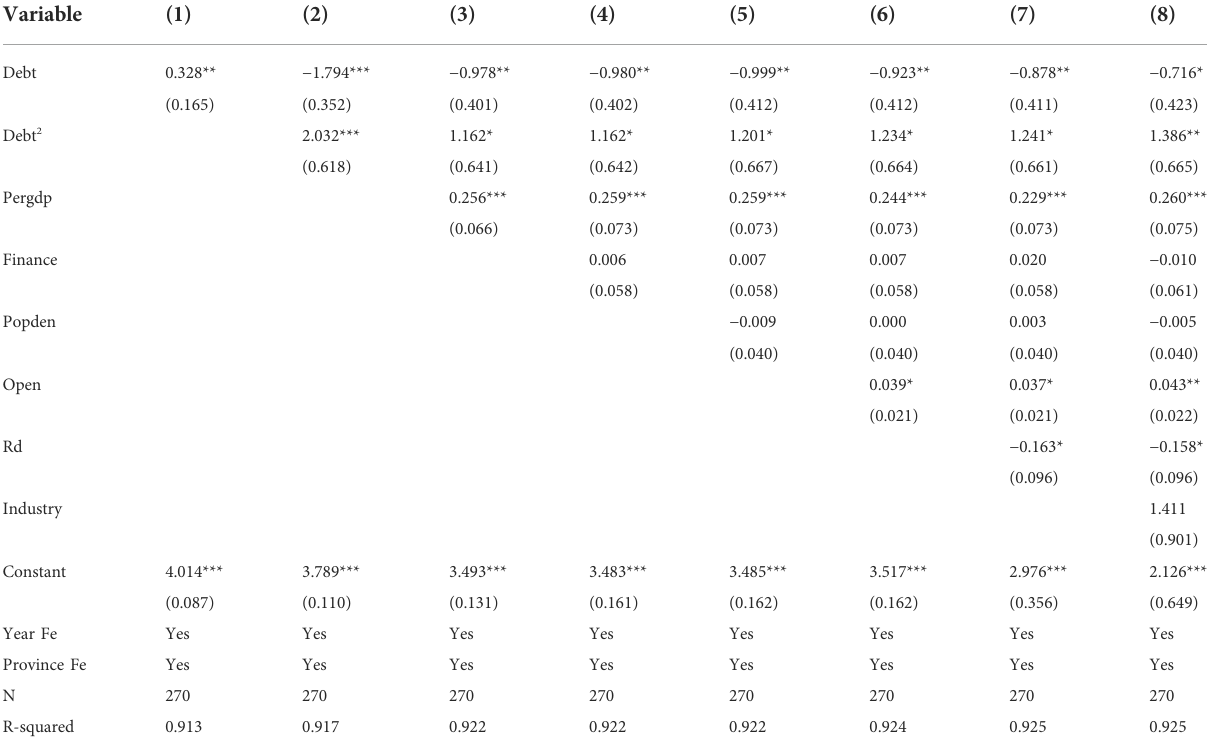
TABLE 2 Results of nonlinear regression based on square term.